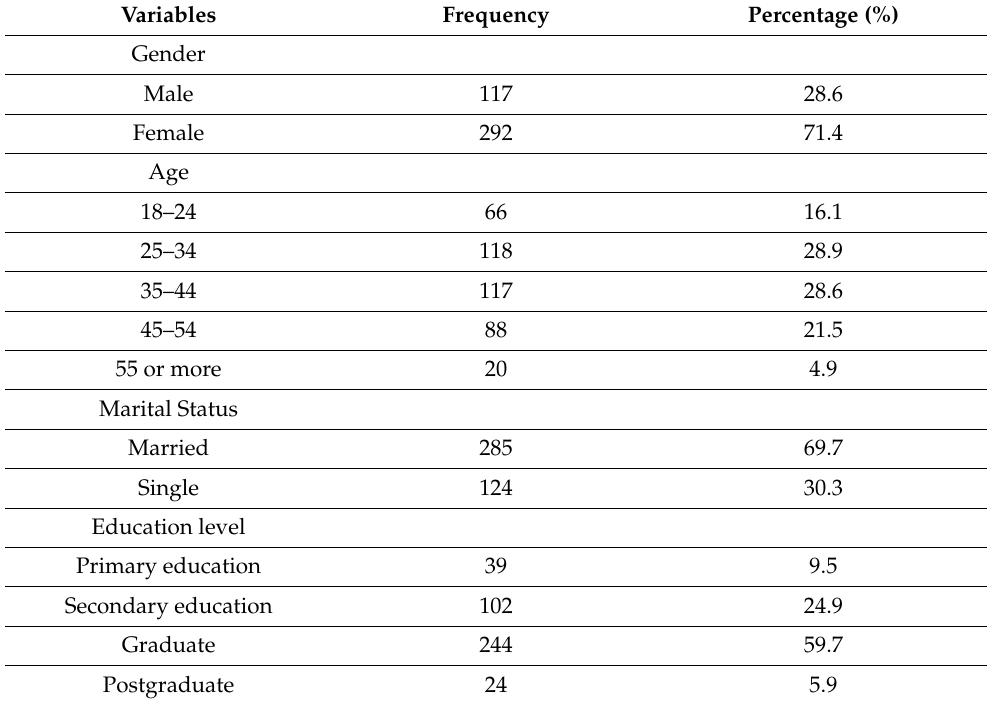
Table 1. Description of the Participants ( n =